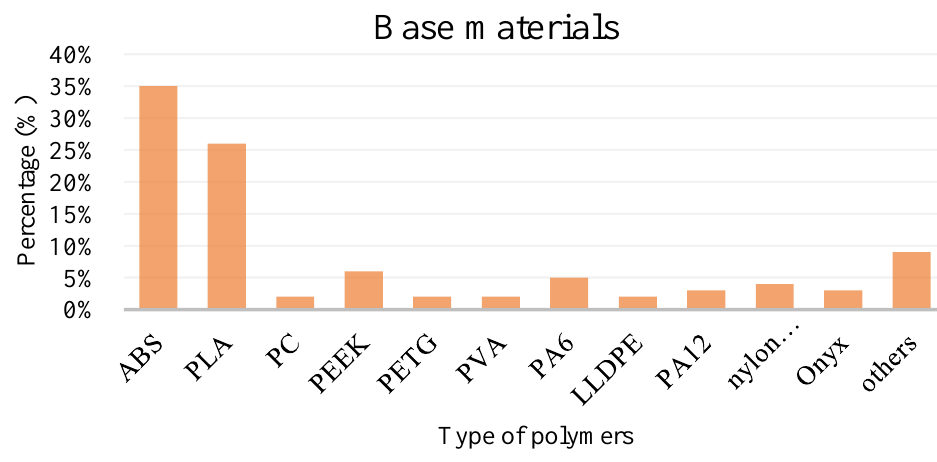
Figure 5. Type of polymer used as a base material in the FDM process.